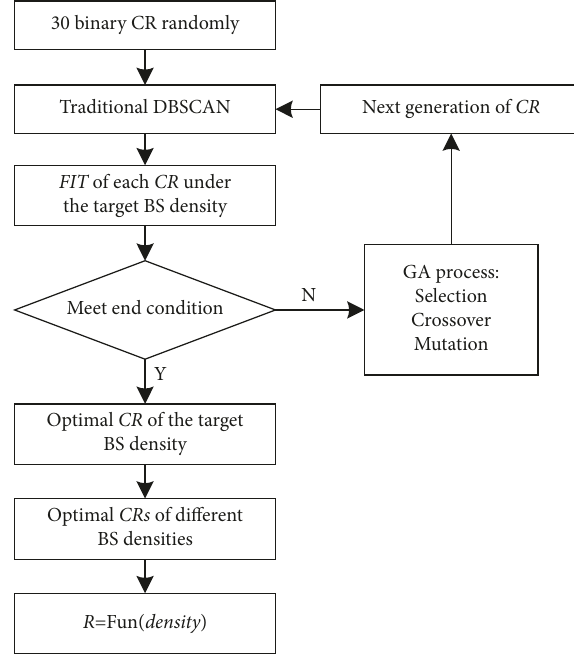
Figure 5: Flowchart of GA-DBSCAN